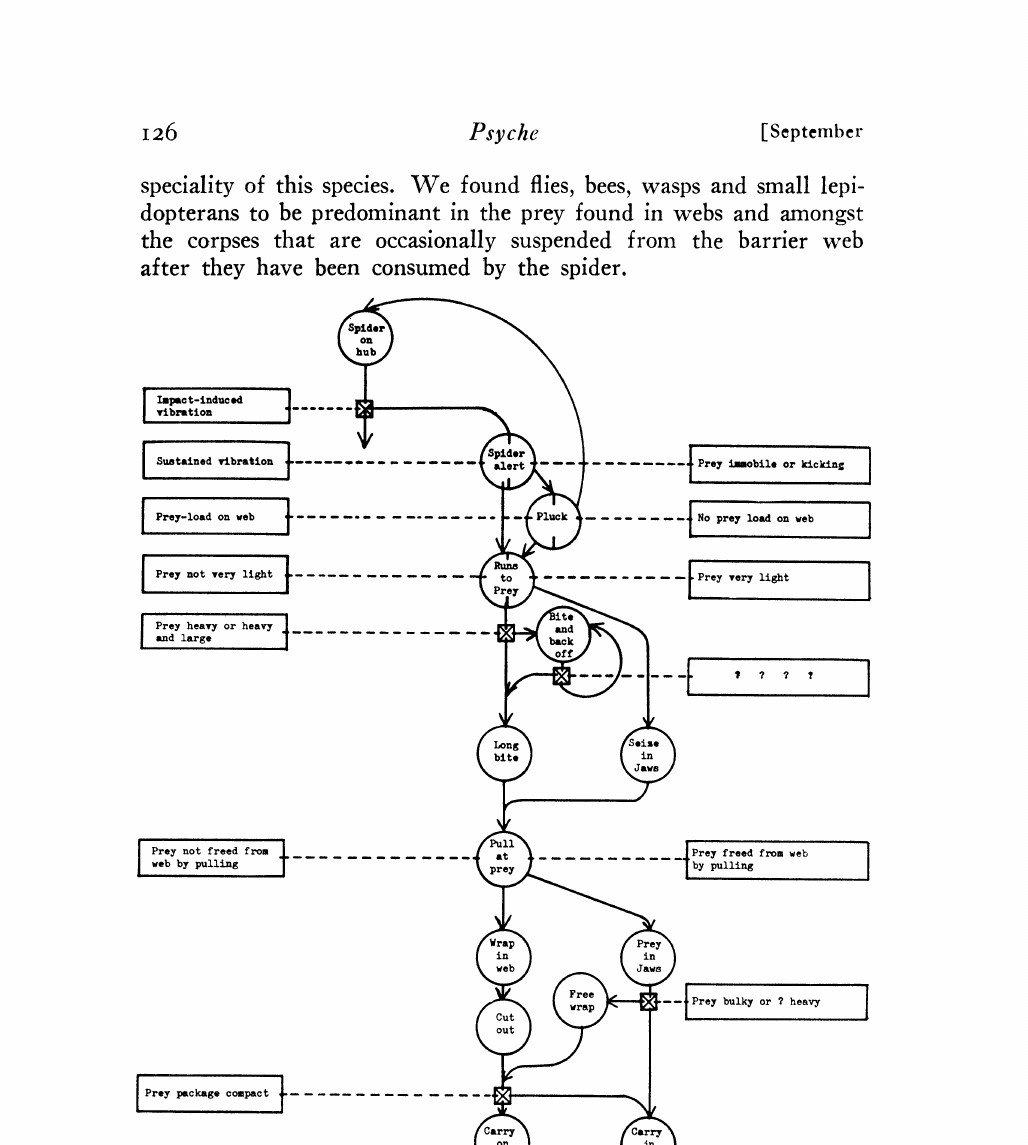
Figure 1. Model of predatory behavior of NeIhila